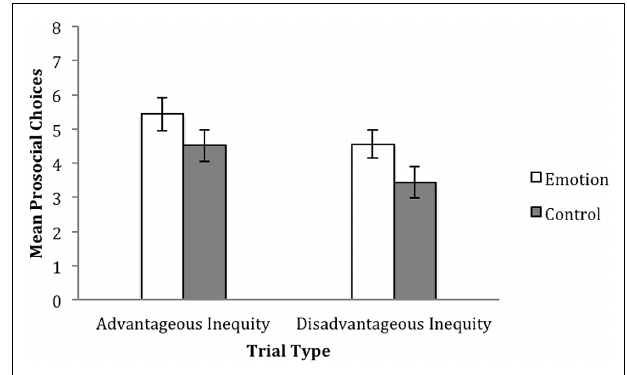
FIGURE 2 | Mean prosocial choices on the resource allocation task with standard error bars, for the emotion induction, and control group, inAI and DI trials in study one (5–6 year-olds). Possible scores ranged from “0” (no prosocial behavior) to “8” (consistent prosocial